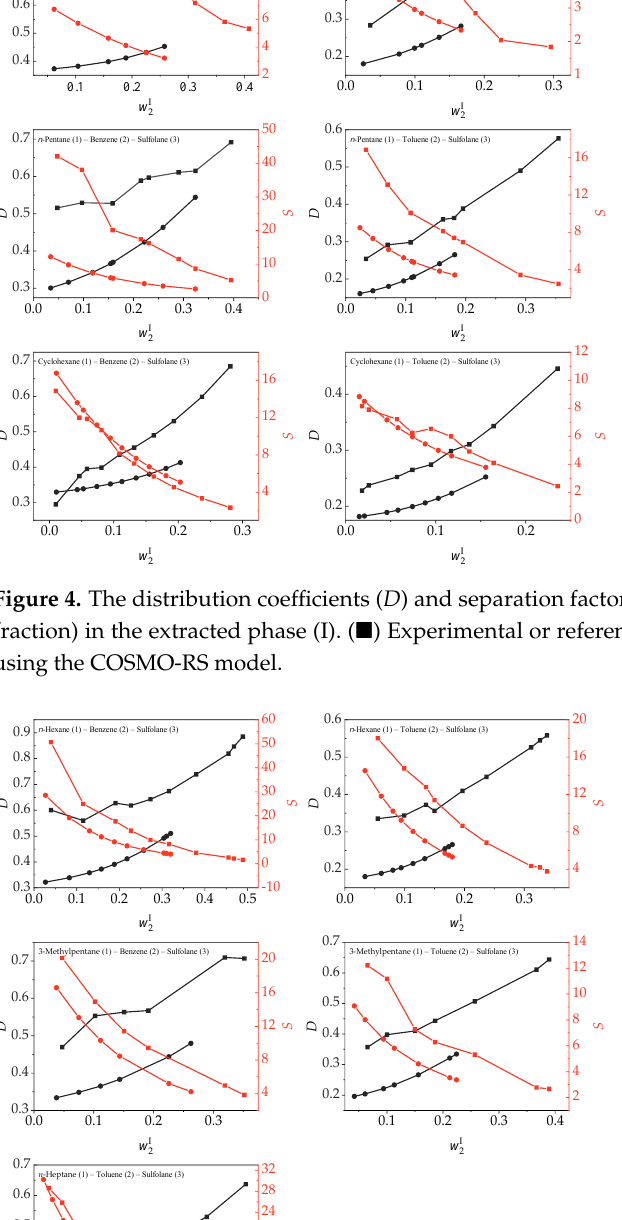
calculations were greater than one, indicating that the predicted separation of aromatic and non-aromatic compounds based on the COSMO-RS model is reliable.